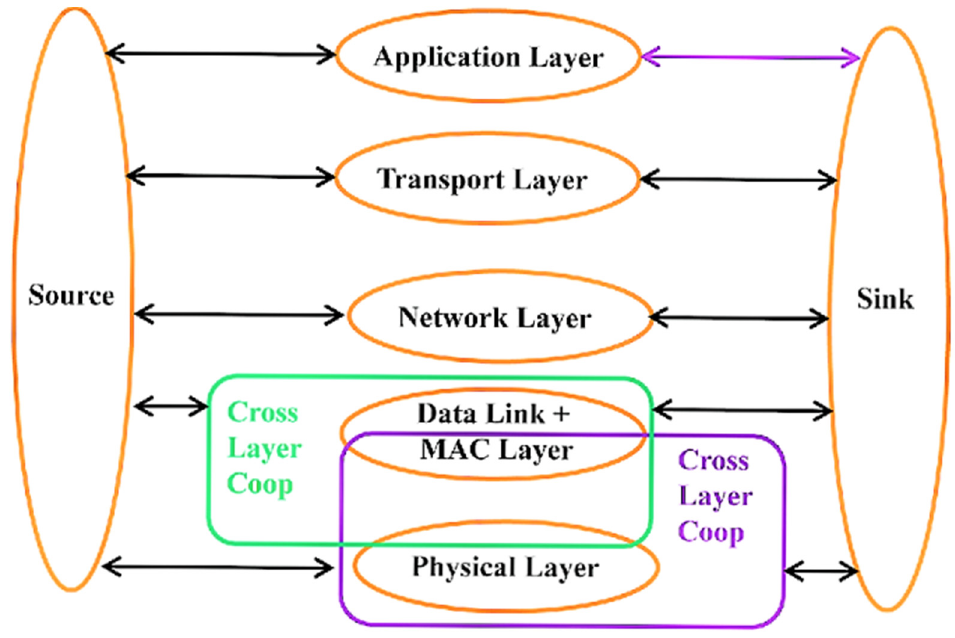
Figure 2. OSI layered model for MAC security.